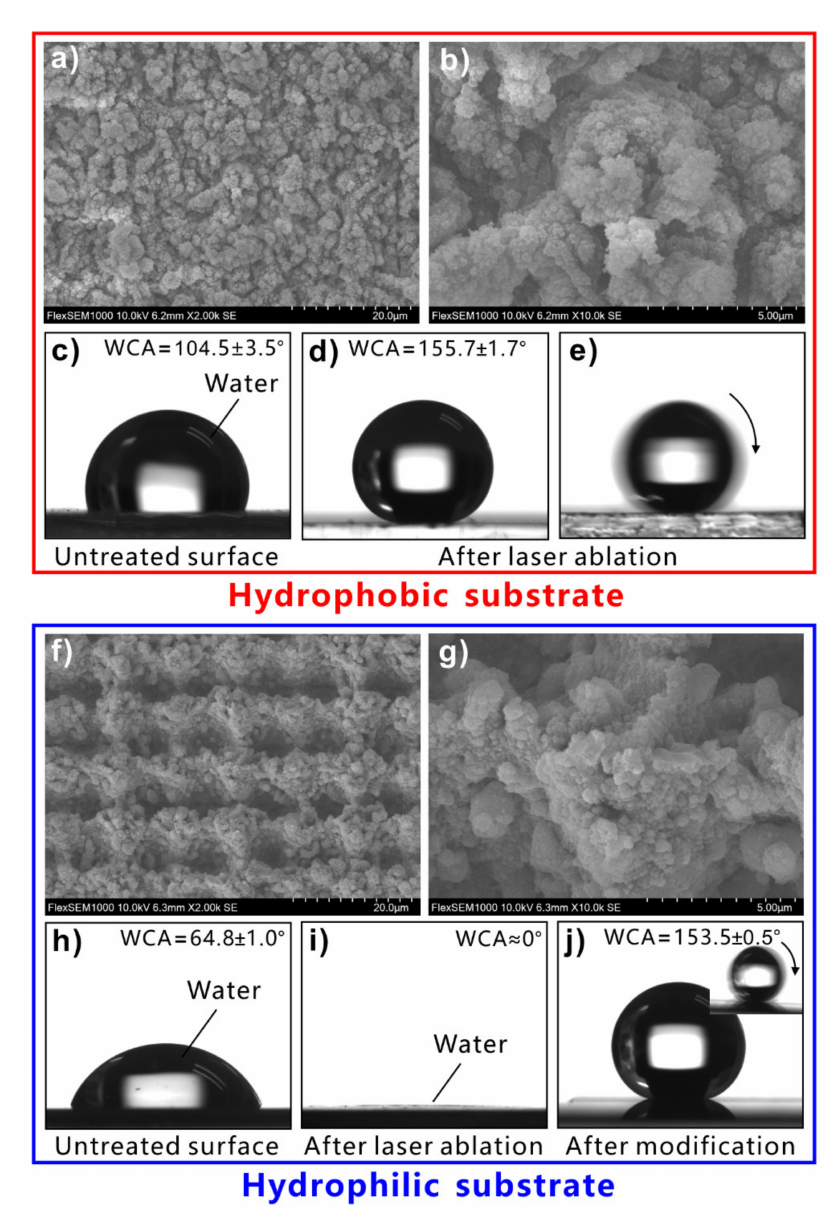
Figure 4. Achievement of superhydrophobicity on ( a – e ) hydrophobic PDMS substrate and ( f – j ) hydrophilic silicon substrate. ( a , b ) Hierarchical microstructures prepared by laser processing on the PDMS surface. ( c , d ) A drop of water on ( c ) the untreated flat PDMS substrate and ( d ) the structured PDMS surface. ( e ) Water droplet rolling away on the structured PDMS. ( f , g ) Hierarchical microstructures prepared by laser processing on the silicon surface. ( h – j ) A drop of water on ( h ) the untreated flat silicon surface, ( i ) the structured silicon surface, and ( j ) the structured silicon surface modified with low-surface-energy chemistry. The inset in ( j ) shows the rolling process of a water droplet on the resultant silicon surface. Reprinted with permission from ref. [151]. Copyright 2020, WILEY-VCH Verlag GmbH & Co.